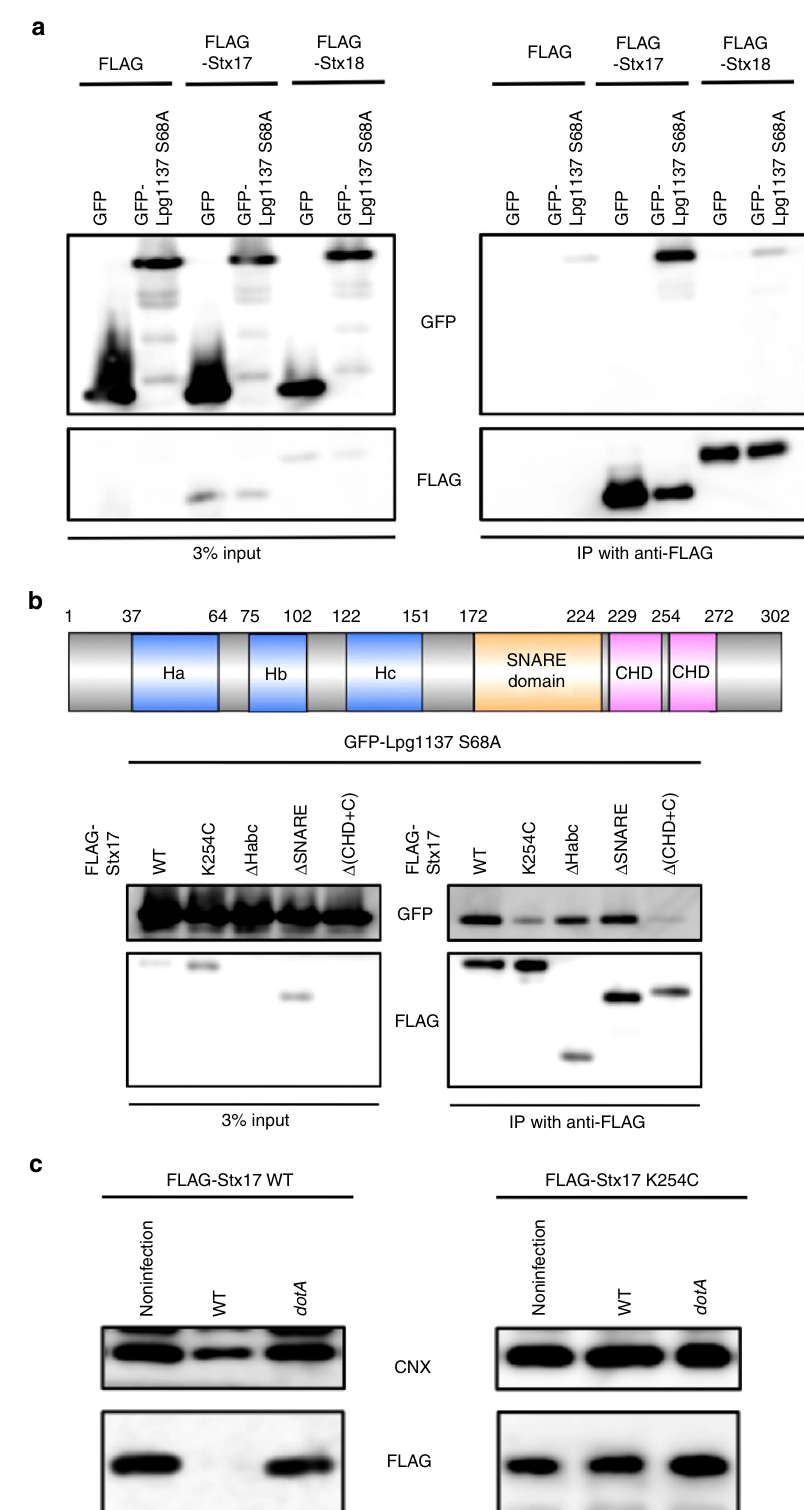
Figure 4 | Stx17 interacts with Lpg1137 through the CHD þ C region. ( a ) HEK293-Fc g RII cells were co-transfected with plasmids encoding GFP-Lpg1137 S68A and either FLAG, FLAG-Stx17 or FLAG-Stx18. At 24h after transfection, cell lysates were prepared and immunoprecipitated with FLAG-M2 beads. The precipitated proteins were analysed by IB with antibodies against GFP and FLAG. ( b ) Schematic representation of Stx17 (upper panel). HEK293-Fc g RII cells were co-transfected with plasmids encoding GFP-Lpg1137 S68A and FLAG-tagged full-length Stx17 or one of its mutants. Cell lysates were immunoprecipitated and analysed by IB with antibodies against GFP and FLAG (lower panel). ( c ) HeLa cells stably expressing FLAG-tagged wild-type (WT) Stx17 or the K254C mutant were transfected with a plasmid encoding non-tagged Fc g RII. At 24h after transfection, cells were non-infected or infected with WT Legionella or a dotA mutant at an MOI of 50 for 4h. Equal amounts of cell lysates were analysed by IB with antibodies against CNX and FLAG. Uncropped images of blots are shown in Supplementary Fig.